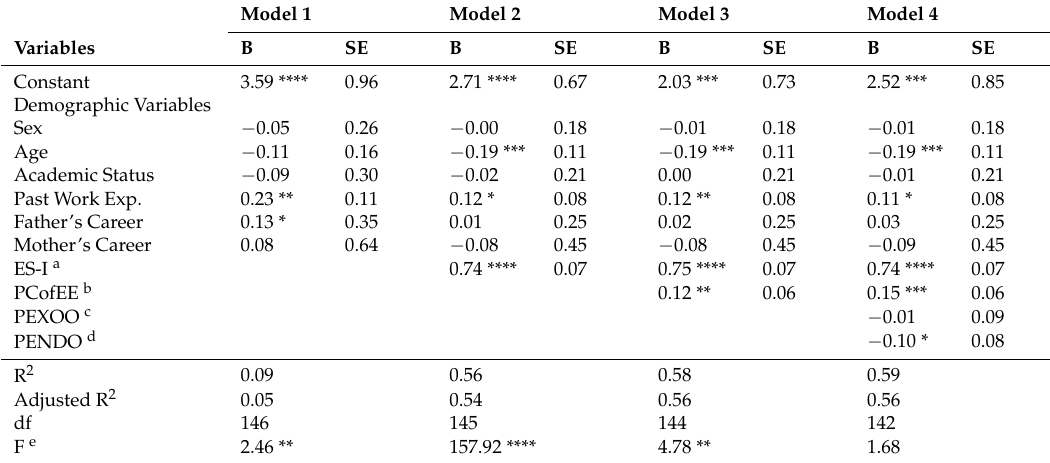
Table 2. Summary of hierarchical multiple regression analysis for variables predicting entrepreneurial